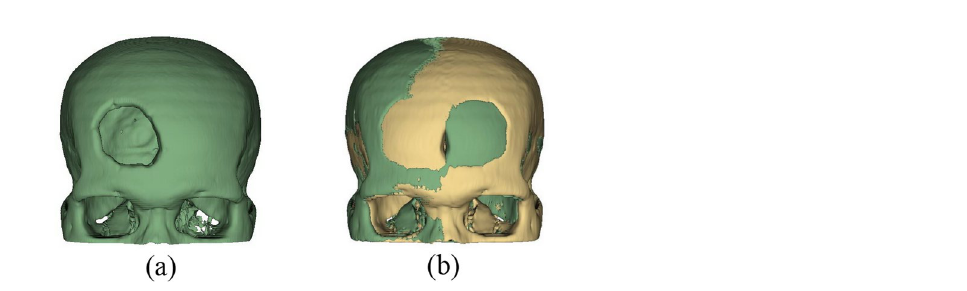
Figure 5. Mirror based modelling creates ( a ) the mirror model and ( b ) the overlayed model between the original model and its mirror version.